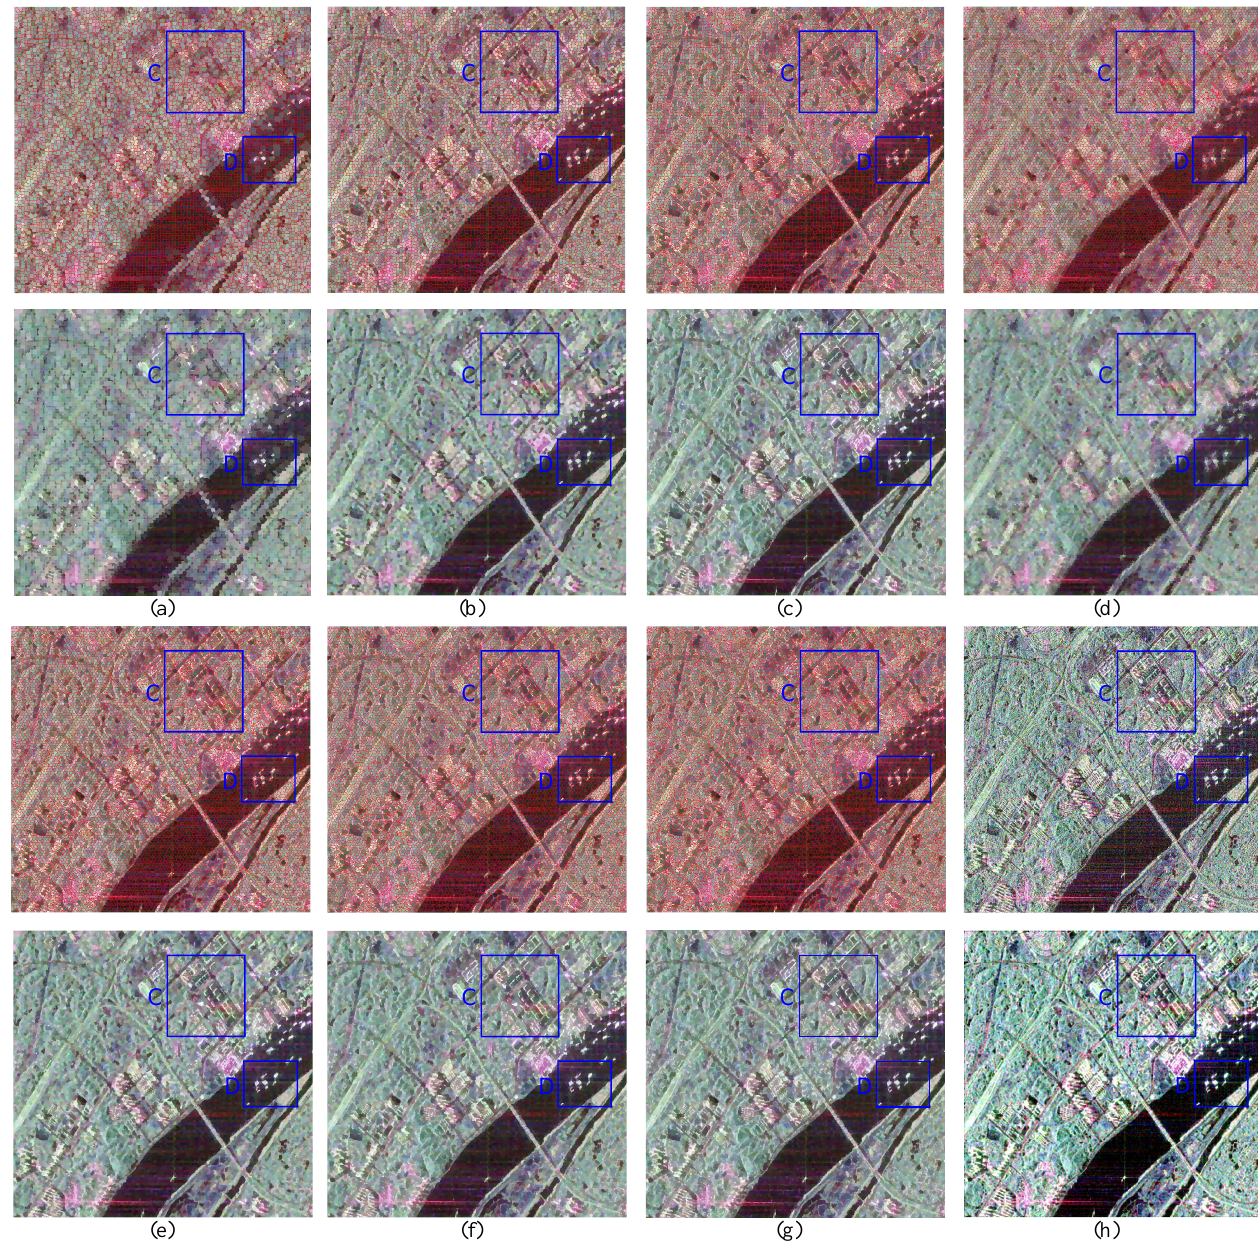
Figure 19. Qualitative evaluation results of data set 5. ( a ) POL-SLIC. ( b ) POL-LSC. ( c ) POL-HLT. ( d ) HAGS. ( e ) HAWS. ( f ) HAHS. ( g ) The proposed HADS. ( h ) Pauli-RGB image.